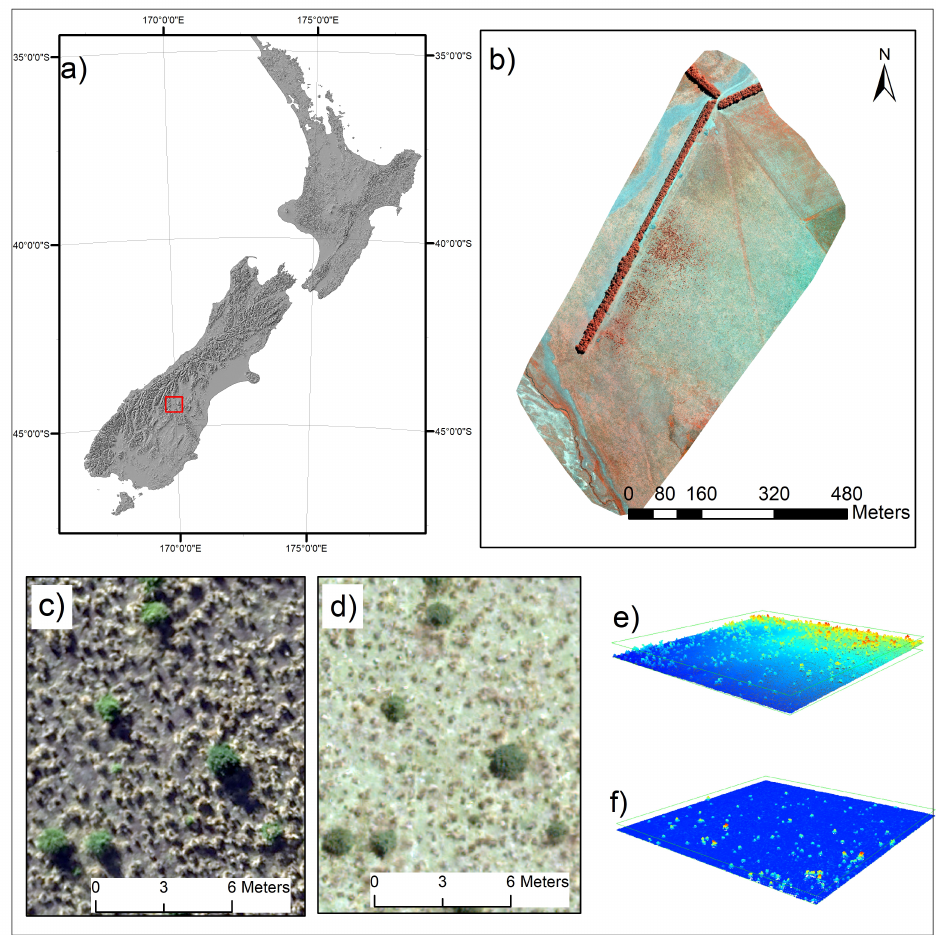
Figure 2. ( a )The location of the Mackenzie Basin within New Zealand, outlined in red over a shaded relief map, ( b ) an overview of the site, ( c ) a close up of the UAV imagery used in the study, ( d ) a close up of the manned aircraft imagery used in the study, ( e ) a part of the UAV-LS point cloud, and ( f ) a part of the ALS point cloud collected from the manned